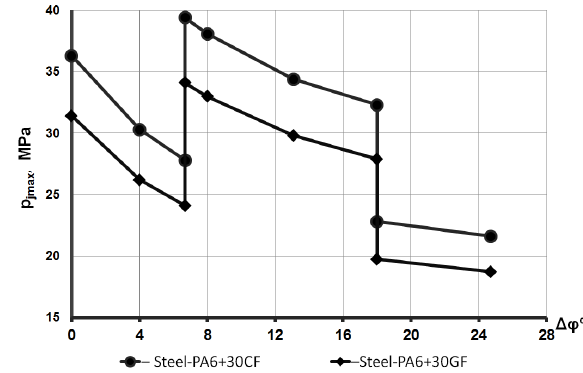
Figure 4. The change of the maximum initial pressures in the process of teeth engagement in MP gear trains. Figure 2. The influence of the friction coefficient on the relative durability of gear trains: (Steel-Steel)/(Steel- The dependences of the change p in the enga- j max PA6+30GF), (Steel- PA6+30CF)/(Steel-PA6+30GF), gement cycle and p after reaching the allowable jh max (Steel- PA6+30CF)/(Steel-Steel). wear at the point of entry of the teeth into the single-pair An important parameter for gear trains is the load engagement in MP gear trains Steel - PA6 + 30CF and carrying capacity, which is characterized by the level of Steel - PA6 + 30GF are shown in Fig. 5. maximum contact pressures p in the engagement. j max Fig. 3 for MM gear train shows the calculated values of (solid line) and both the initial contact pressures p j max their change p (dashed lines) as a result of the teeth jh max = 0.5 mm when changing the wear to a value of h * friction coefficient. The left and right areas of the diagram correspond to the two-pairs engagement, and the central area corresponds to the single-pair engagement.